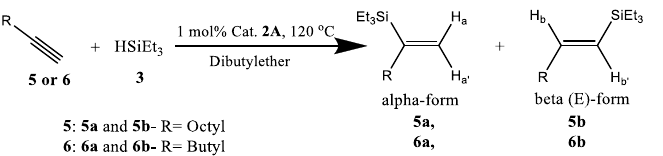
Table 3. Hydrosilylation reaction of 1-decyne ( 5 ) and triethylsilane ( 3 ) under thermo- morphic